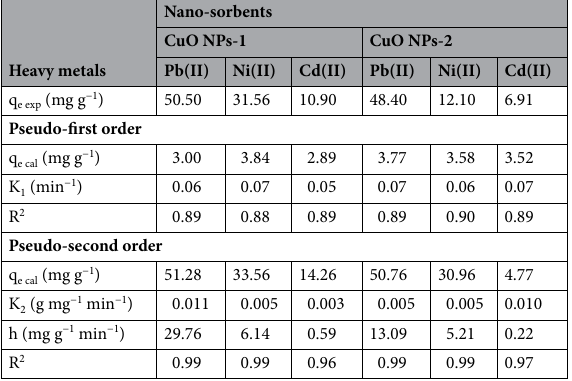
Table 2. Kinetic parameters and correlation coefficients for the investigated heavy metals using nano-sorbents (CuO NPs-1 and CuO NPs-2).